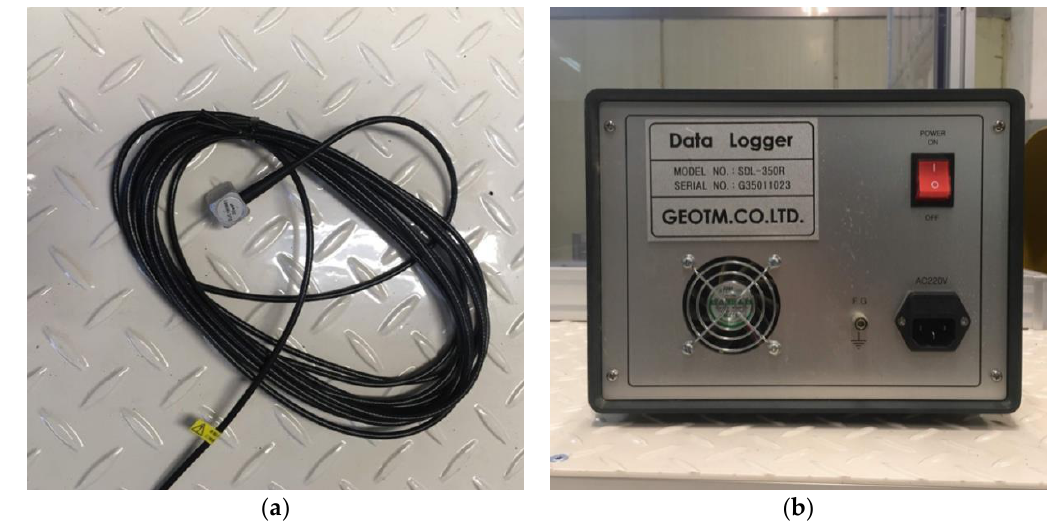
Figure 4. Instrumentation: ( a ) Accelerometer; ( b ) Data logger.